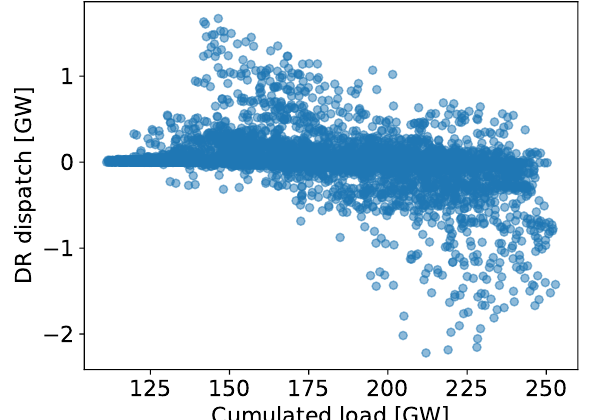
Figure 4. Correlation of the DR dispatch and the cumulated system load (each point represents one hour of the year).